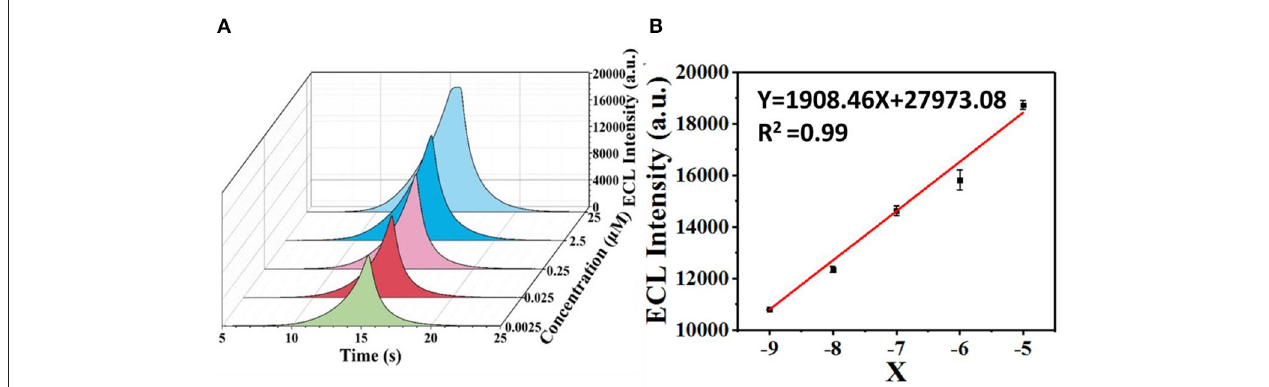
FIGURE 9 | Determination of the limit of ECL detection of sunset yellow. (A) ECL intensities over time at different concentrations of sunset yellow. (B) Logarithmic calibration curve of the sunset yellow biosensor [X = Lg (C/2.5)].